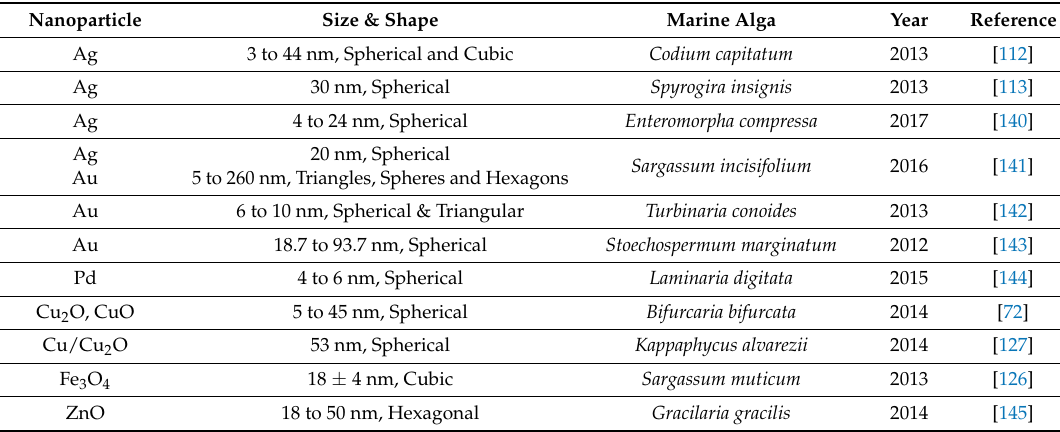
Table 2. A selection of nanoparticles biosynthesised using marine plant